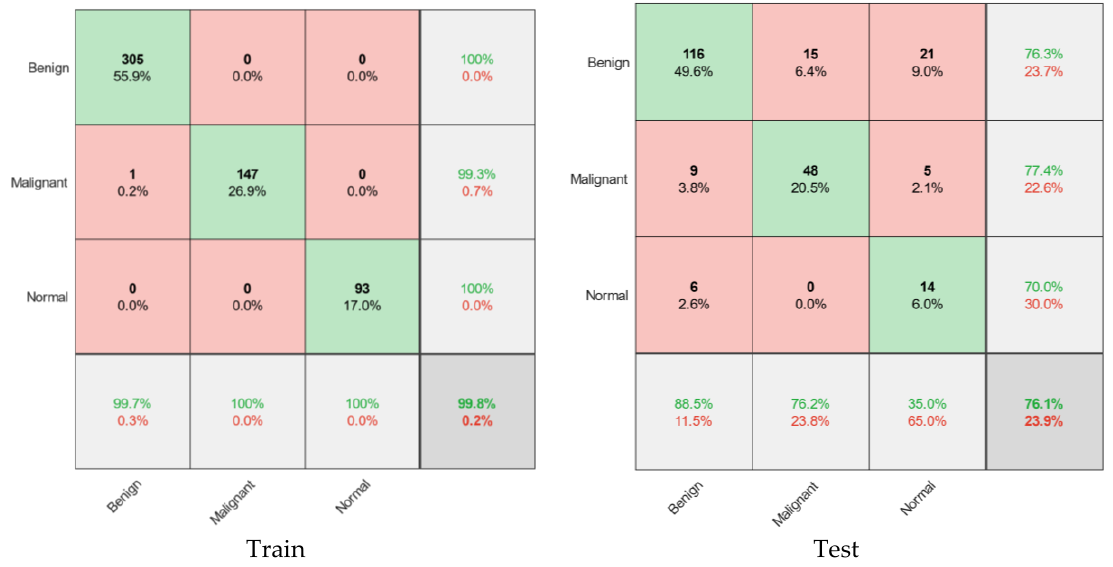
Figure 6. The confusion matrix for the training and test set for the proposed CNN model. Regarding the test results, out of 131 benign experimental images, 116 images were correctly detected. In other words, this diagnosis was associated with 88.5% sensitivity. In addition, out of 63 malignant images, 48 images (76.2%) were correctly diagnosed, of which 15 images (23.8%) were misdiagnosed as benign, which are called false results. This